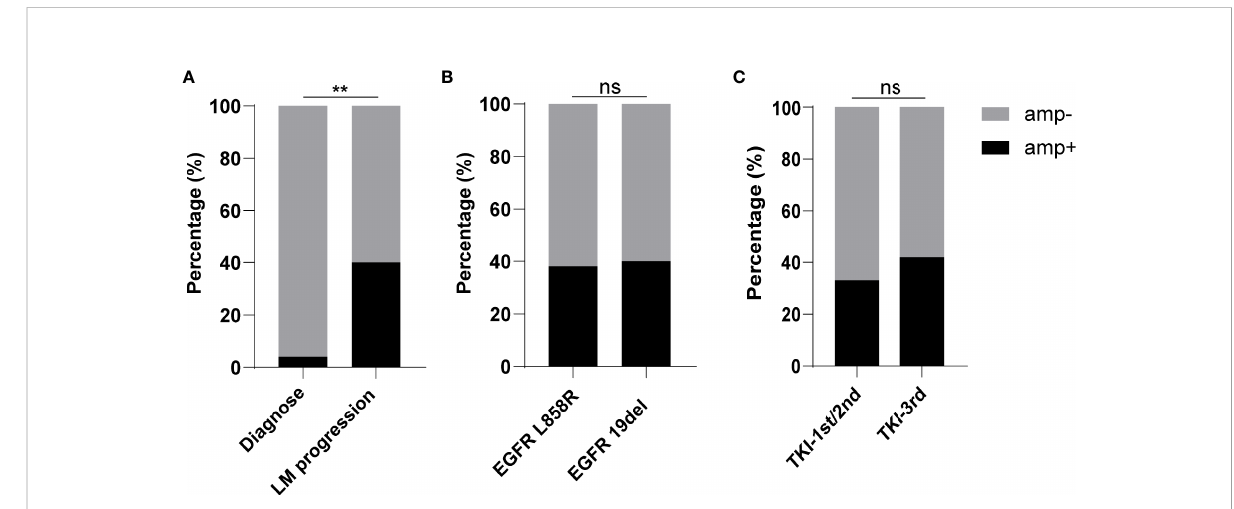
FIGURE 2 Characteristics of patients with or without epidermal growth factor receptor (EGFR) ampli fi cation. (A) Rate of detection of EGFR ampli fi cation at the time of initial diagnosis or leptomeningeal progression. (B) Rate of EGFR ampli fi cation in non-small cell lung cancer – leptomeningeal metastases patients harboring EGFR L858R or EGFR 19del. (C) Rate of EGFR ampli fi cation in patients previously treated with a fi rst- or second- generation tyrosine kinase inhibitor (TKI) or a third-generation TKI. ** demonstrated p<0.01, and ns indicated no signi fi